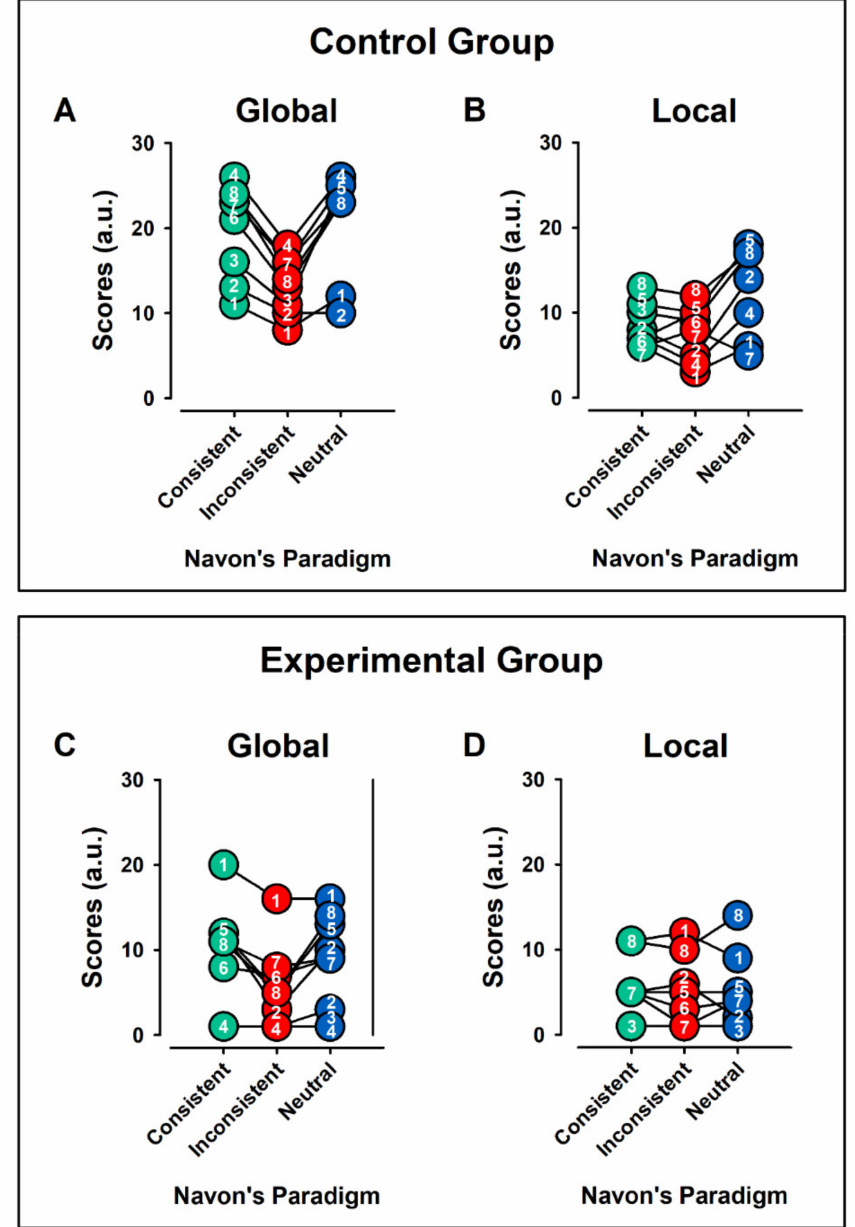
Figure 6. Pooled data of scores for all individuals, in Global ( A , C ) and Local ( B , D ) Aspect Recog- nition for control and experimental group, respectively. The individual values for each subject are represented with a number. In each case, the consistent, inconsistent, and neutral conditions are displayed. Note the interindividual differences. We observed higher values of scores in consistent Global Aspect Recognition in both